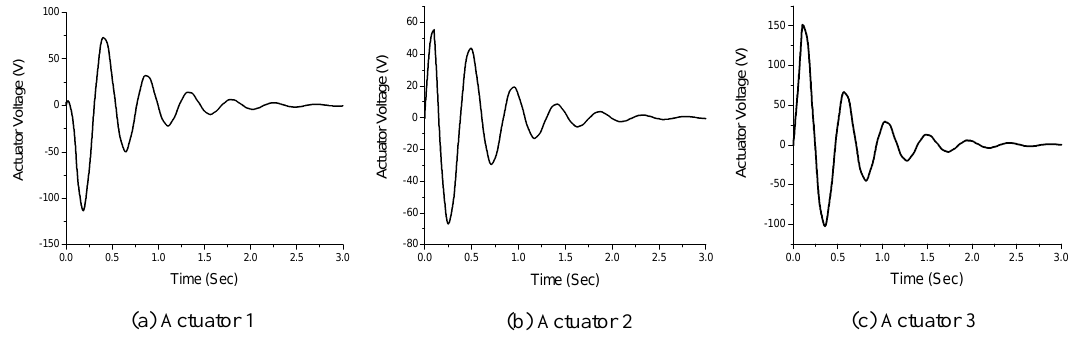
Fig. 7. Time history of actuator voltage for case 1.